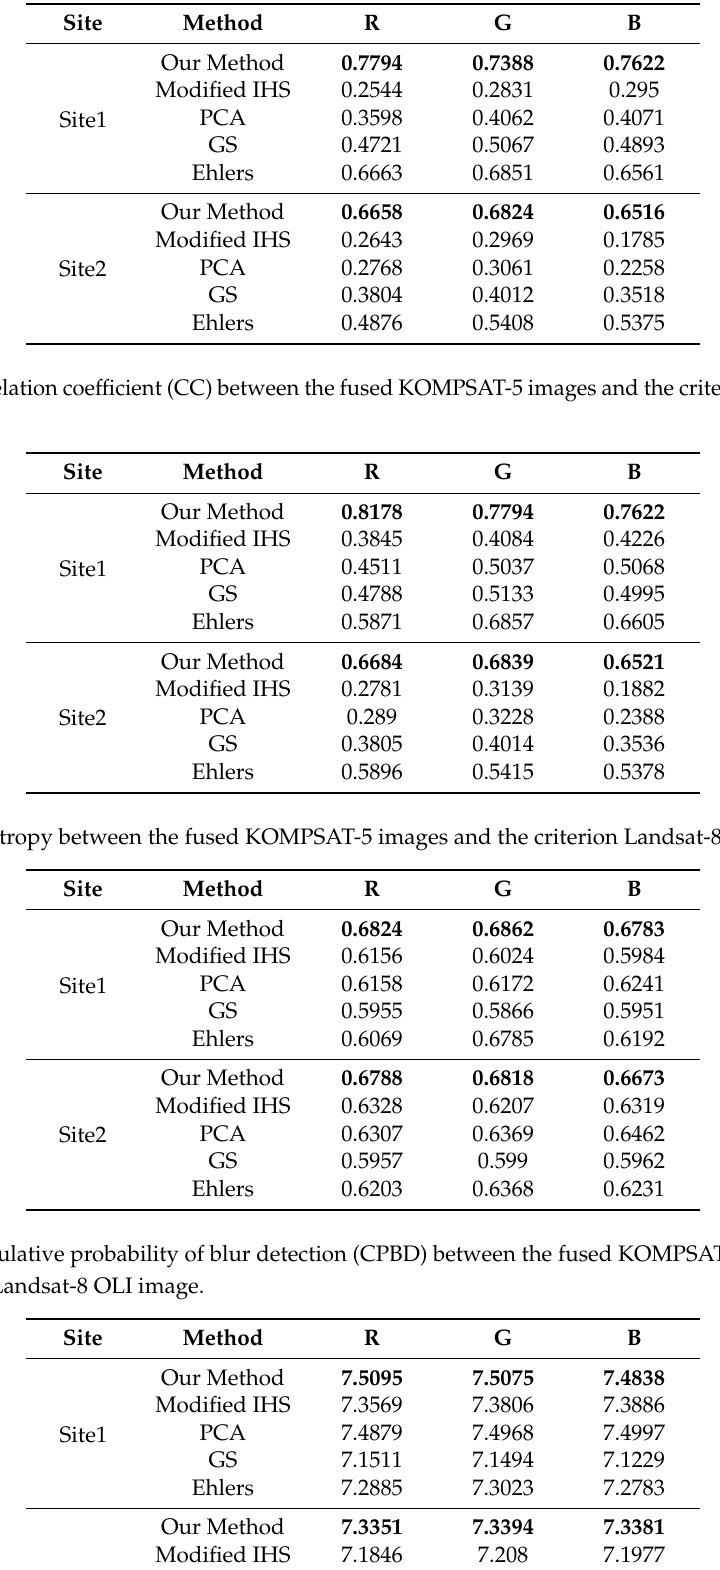
Table 2. UIQI between the fused KOMPSAT-5 images and the criterion Landsat-8 OLI image.